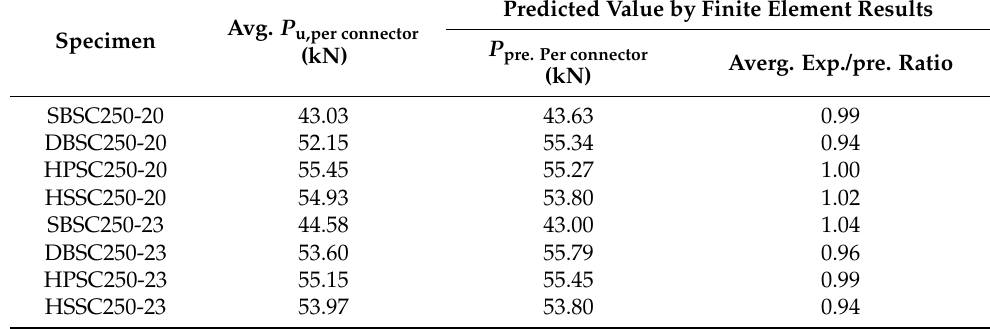
Table 2. Experimental and FE results